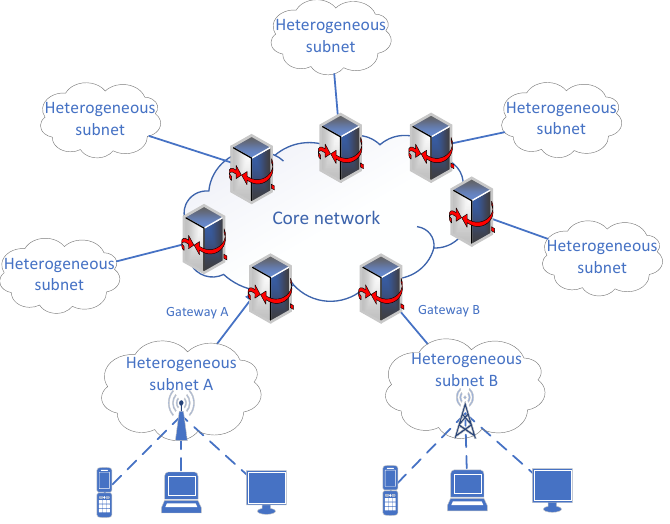
Figure 1. The heterogeneous integrated